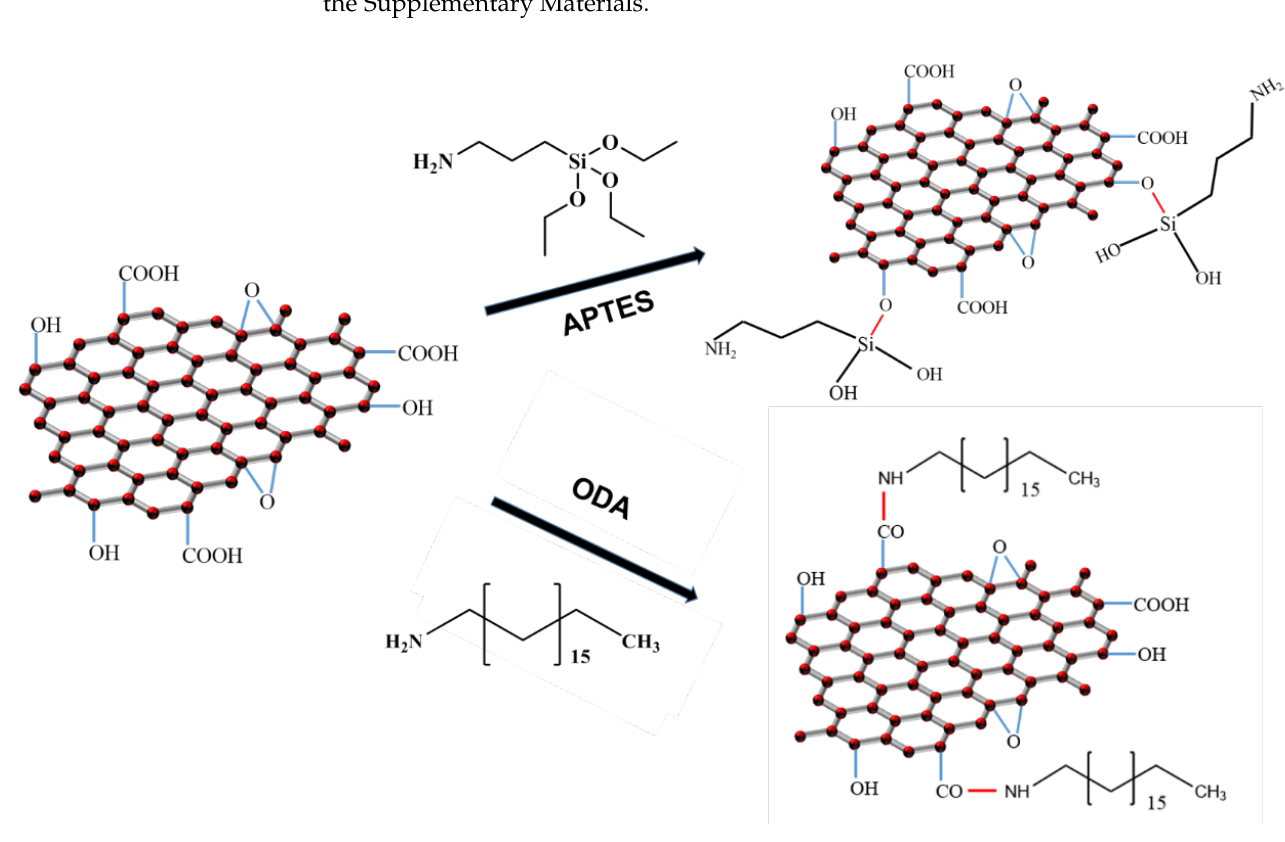
Figure 1. Synthesis of AGO and HGO.